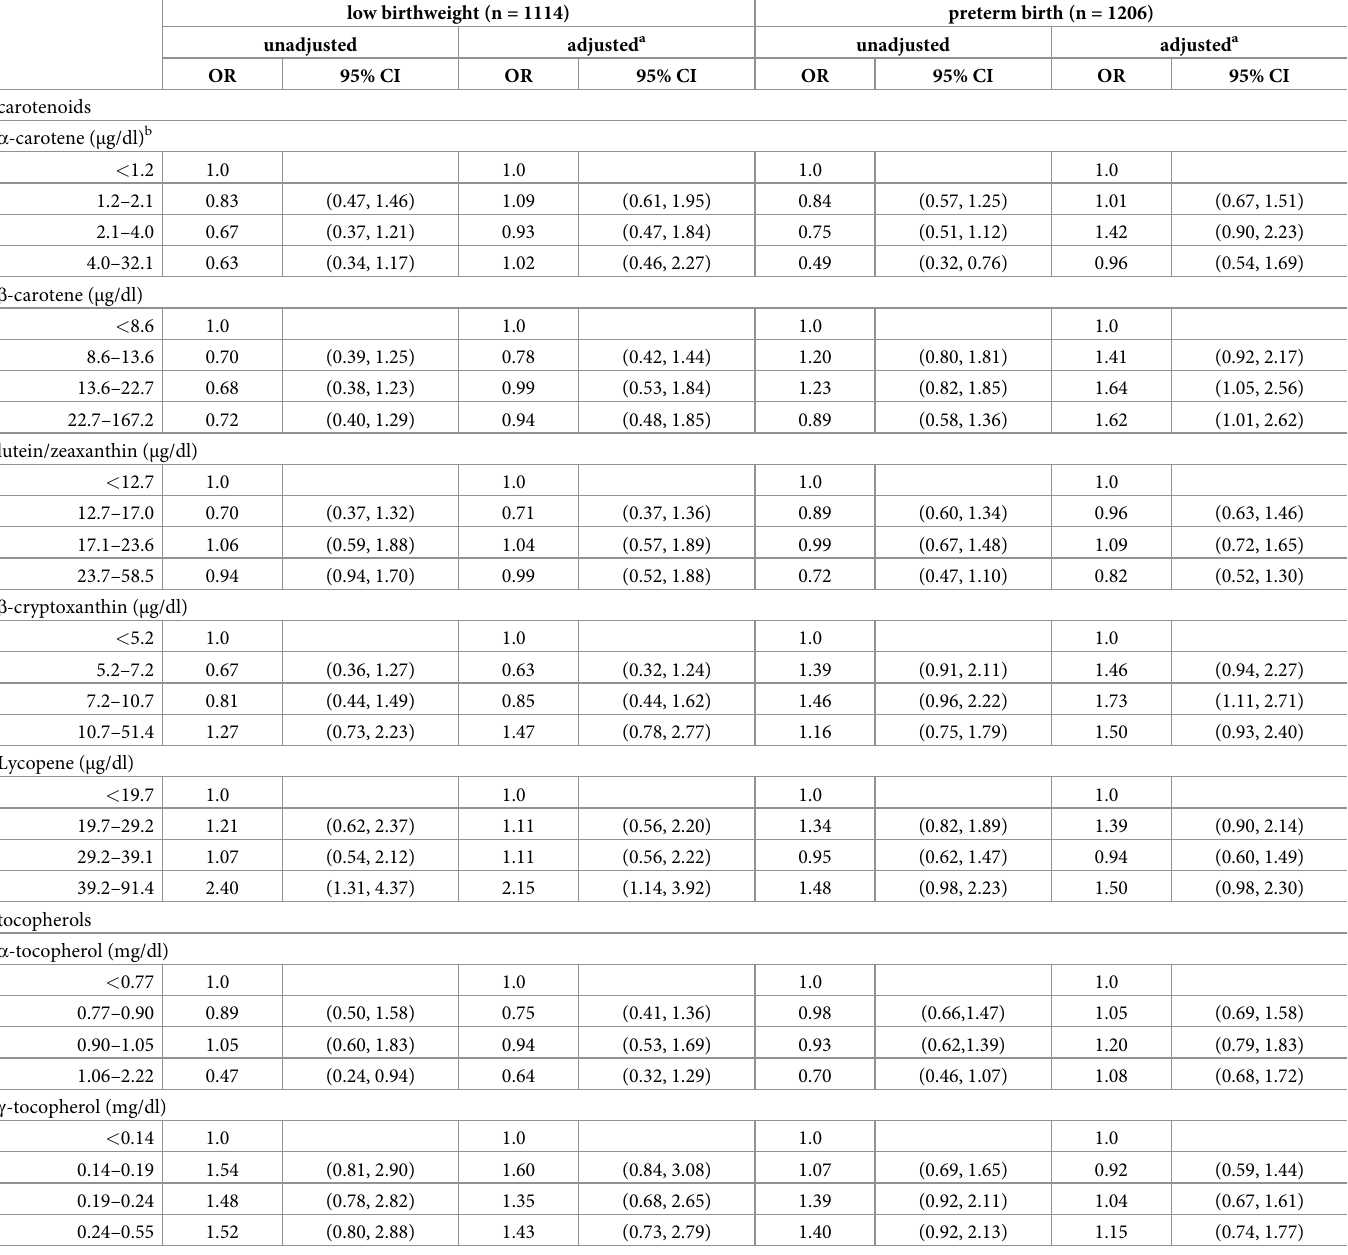
Table 2. Relationship between serum antioxidant status, as quartiles, and subsequent birth